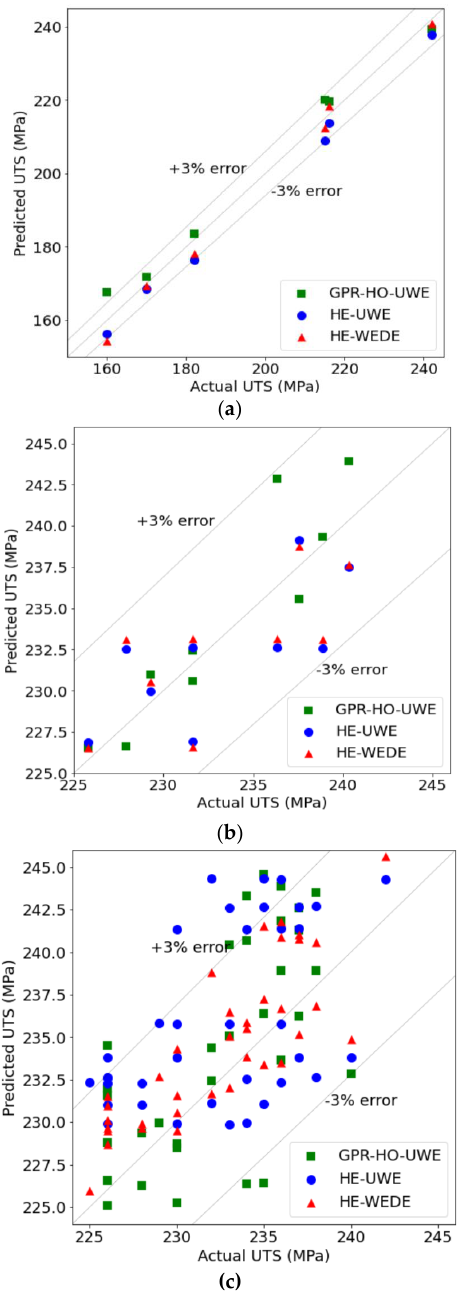
Figure 7. Actual vs. predicted value of UTS for testing data on the ( a ) FSW-2PI, ( b ) FSW-11PI-V1, and ( c ) FSW-11PI-V2 datasets.